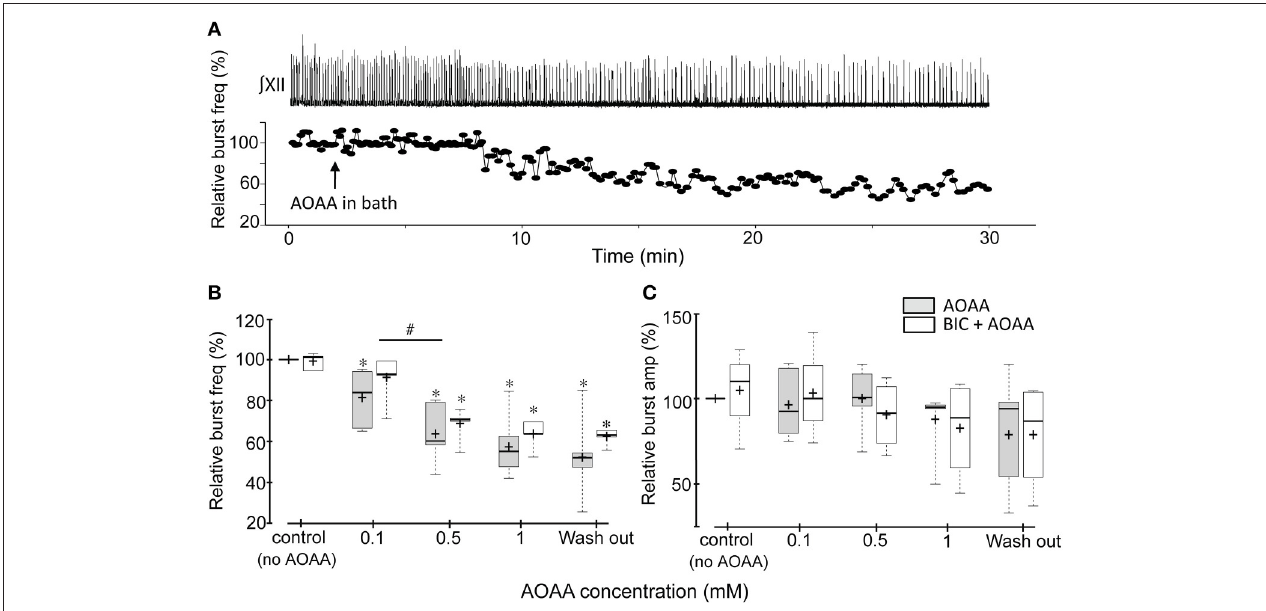
FIGURE 2 | Effects of AOAA on rhythmic inspiratory-related activity recorded from the XII nerve root of medullary slice preparations. (A) Representative medullary slice preparation showing the time course of how instantaneous frequency, calculated from the recordings shown ( R XII nerve, top trace), changes following bath application of 1 mM AOAA (indicated by the black arrow). The time scale of the nerve recordings and instantaneous frequency plots are matched. (B,C) Box plots of group data showing the dose-dependent effects of bath-applied AOAA on the XII inspiratory burst frequency (B) and amplitude (C) of AOAA bath-applied alone ( n = 7), and, in a different group of slice preparations, in combination with bicuculline (3 µ M, n = 7). The effect of bicuculline alone is presented in the control group data set. *indicates significant difference ( p < 0.05) compared to control (baseline), # indicates significant difference ( p < 0.05) between the indicated